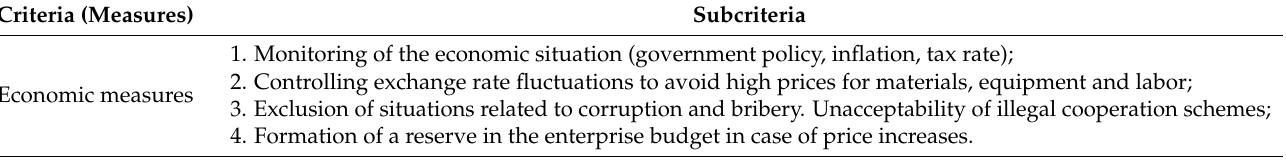
Table 5. Criteria for reducing or limiting the impact of risk factors on the work of construction enterprises.